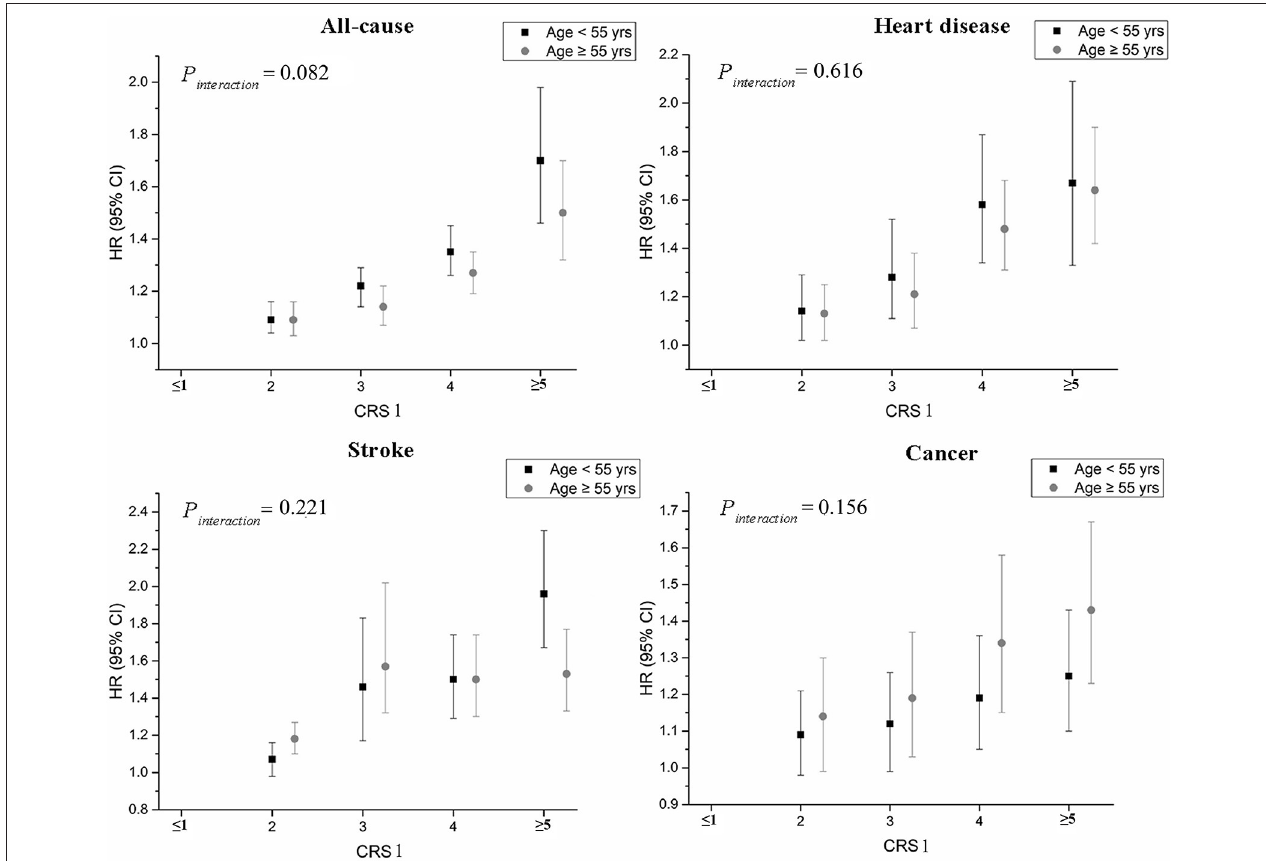
FIGURE 1 | Hazard ratios and 95% confidence intervals for the associations between CRS1 and risk of all-cause and cause-specific mortality by age at baseline in the Linxian Nutrition Intervention Trial Cohort. Age at baseline was divided into two groups ( < 55 years and ≥ 55 years), based on the median value. Multivariable hazard ratios were adjusted for age at baseline, sex, commune, education level, and family history of cancer. CRS, combined risk